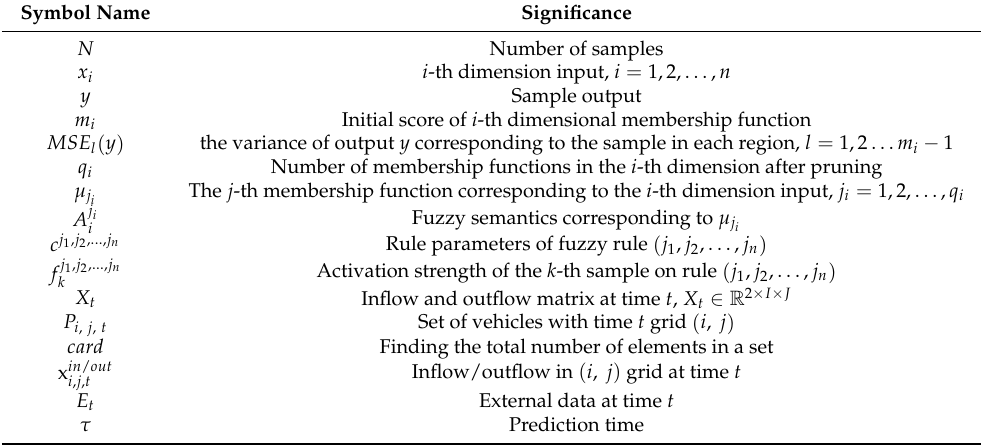
Table 1. List of